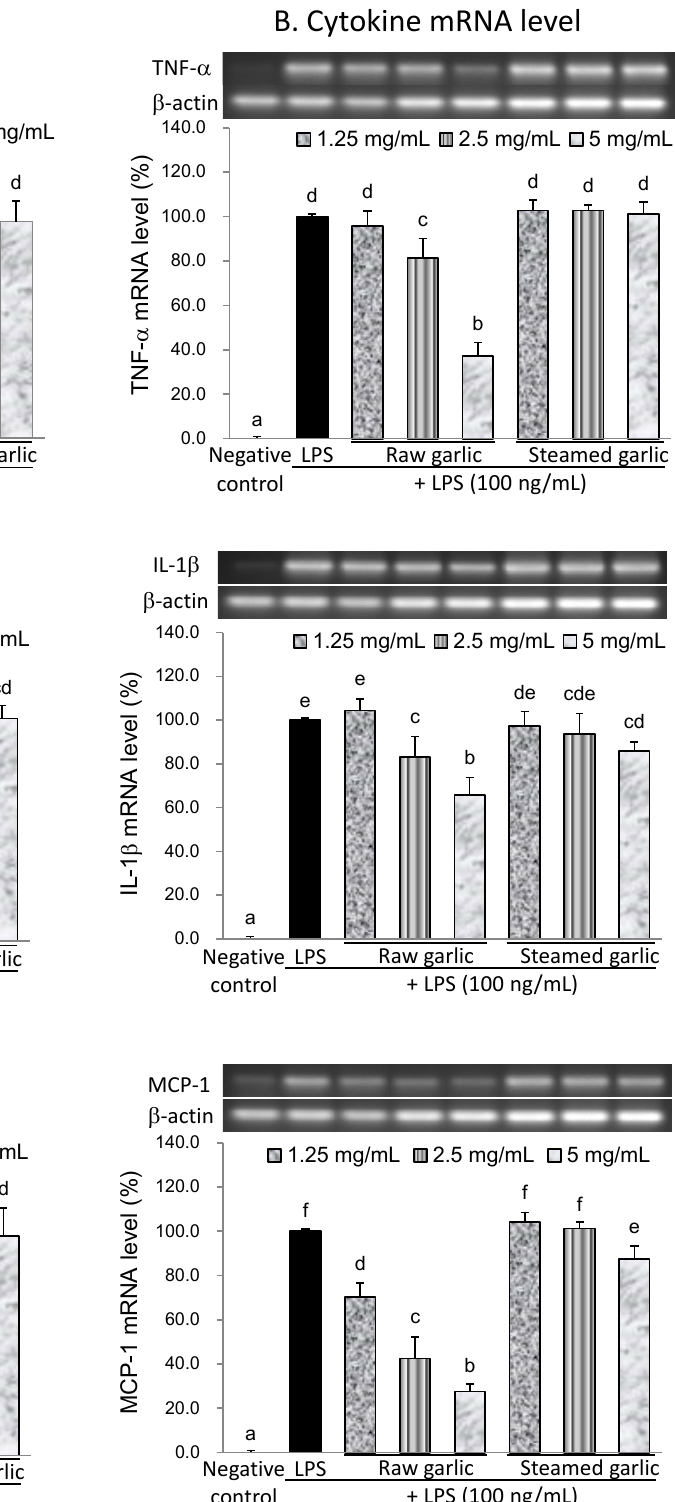
Figure 3. Effects of raw and steamed garlic extracts on TNF-α, IL-1β and MCP-1 secretion ( A ) and mRNA level ( B ) in LPS-activated BV2 microglia. The treatment concentrations of garlic extract are 1.25–5.00 mg/mL. The values are expressed as means ± SD of triplicate tests. Means not sharing a common letter are significantly different ( p < 0.05) when analyzed by ANOVA and Duncan’s multiple range